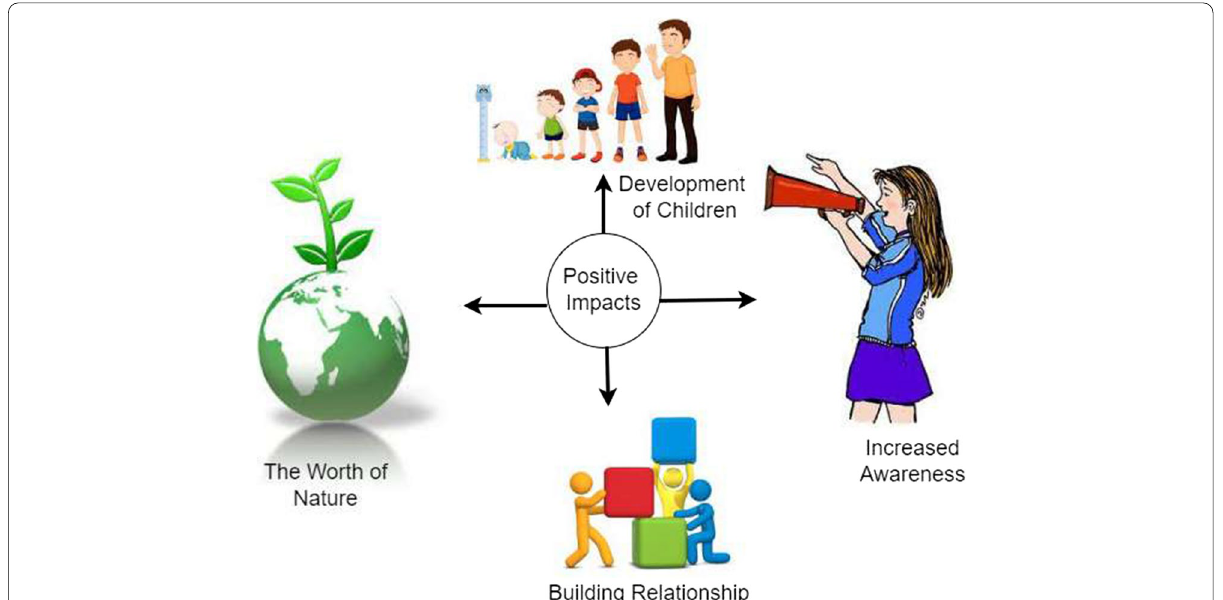
Fig. 2 Positive impacts of COVID on children, the image was drawn by the